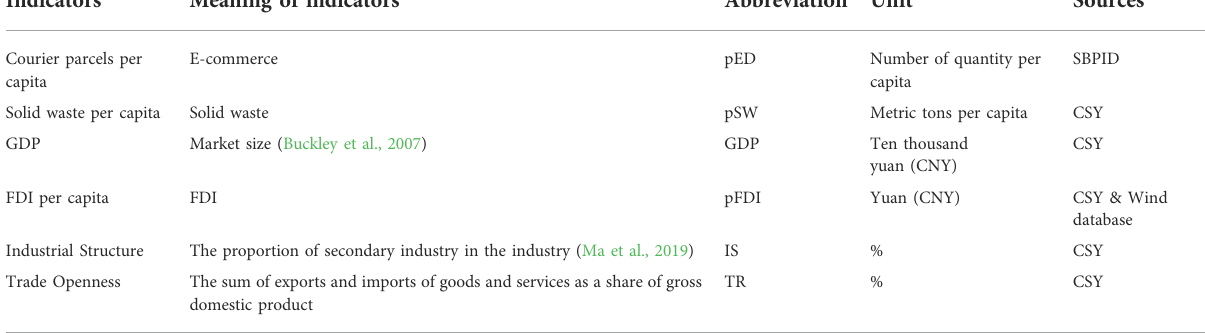
TABLE 1 Data description and